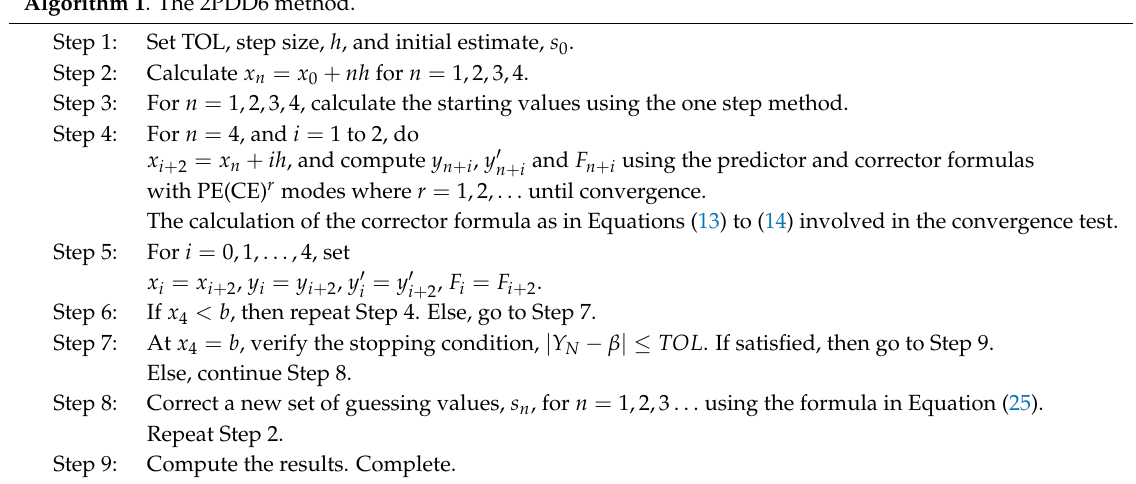
Algorithm 1 . The 2PDD6